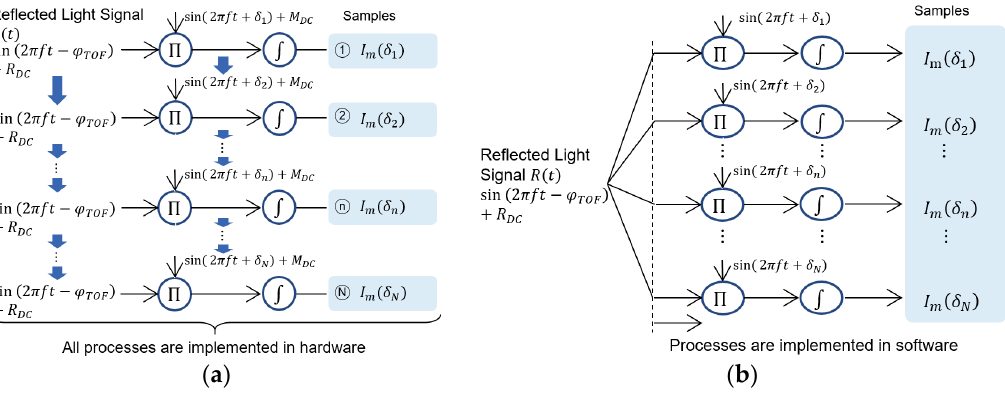
Figure 4. Comparison of sequential phase demodulation and parallel phase demodulation methods. ( a ) Sequential demodulation process of the conventional AMCW method; ( b ) parallel demodulation process of the proposed method.